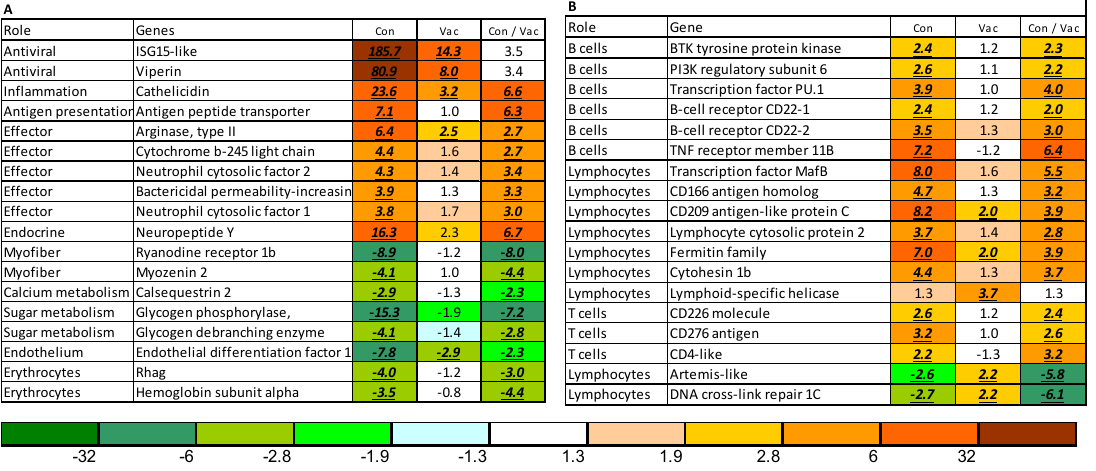
Figure 6. Di ff erentially expressed genes at 21 days post-challenge. Data are the expression ratios (folds) of infected salmon to intact control (first two columns) and saline control to vaccinated fish (third column), highlighted with color scale. Di ff erential expression ( > 1.75-fold; p < 0.05) is indicated with underlined, italic, bold font. ( A ) Inflammation, functional disorders, and heart pathology; ( B ) lymphocyte-specific genes.